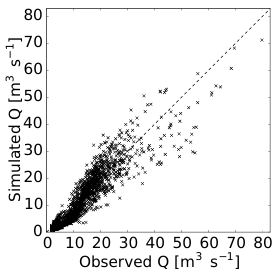
Figure 5. Comparison of observed and simulated daily discharge Q of the Atnsjoen catchment. The dashed black line demonstrates perfect agreement between simulation and